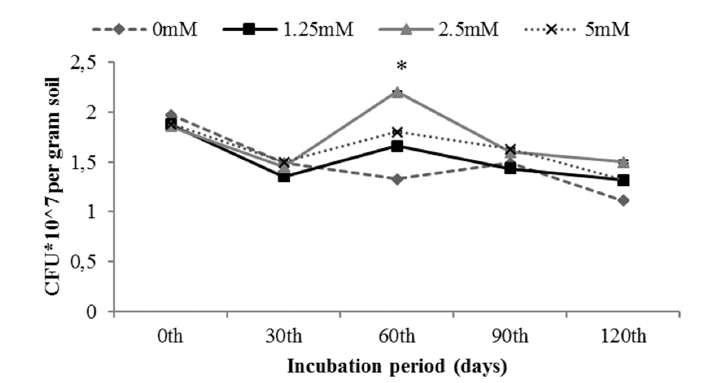
Figure 3. Growth response of Psuedomonas mendocina S10 in soil treated with variant ammonium concentrations 0 mM, 1.25 mM, 2.5 mM, and 5 mM Each data point represents no. of bacterial colonies per gram of soil. One-way ANOVA determined the significance of difference. Each data point represents mean and the vertical line on it indicates the standard error. The asterisk shows significance level: p<0.05 with 0-day samples.